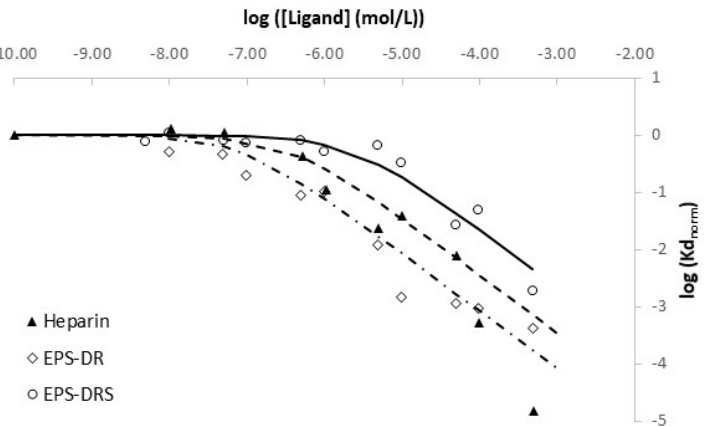
Figure 6. Ligand concentration isotherms of EPS-DR, EPS-DRS and Heparin: pH = 6.1 ± 0.1; 10 mg of chelex 100 resin in 5 mL of solutions; [Sc 3+ ] = 10 − 4 mol L − 1 , [EPS-DR], [EPS-DRS] and [Hep] ranged from 10 − 10 to 5.10 − 4 mol L − 1 .